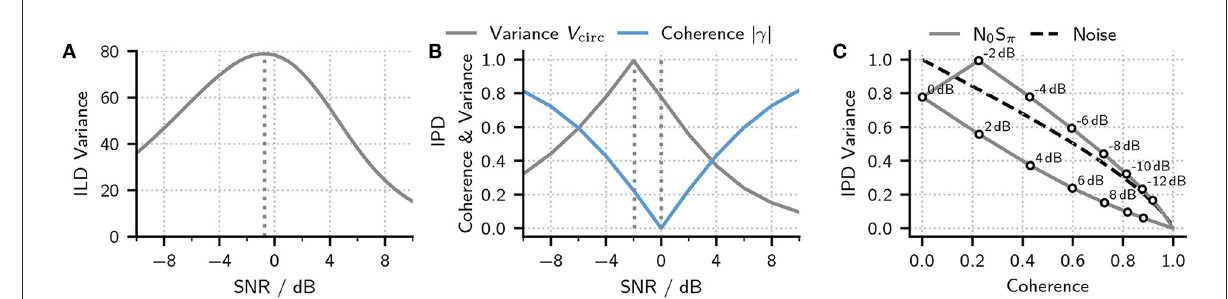
FIGURE5 (A) Variance of ILDs in an N 0 S π signal calculated at different SNRs. The dashed line marks the maximum of the function (B) Circular IPD variance in an N 0 S π signal calculated at different SNRs (blue line) and the matching interaural coherence (gray line). Dotted lines indicate the location of the maximum in variance and minimum in coherence. (C) Circular IPD variance as a function of stimulus coherence for an N 0 S π stimulus (gray line and symbols) as well as (partly) decorrelated noise (dashed black line) (Just and Bamler, 1994). Symbols and labels indicate SNRs resulting in a given combination of coherence and